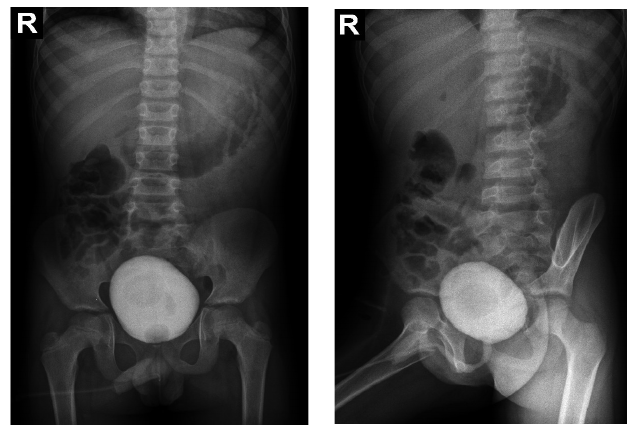
Figure 1. Voiding mictional cystourethrogram. Table 1. Imaging